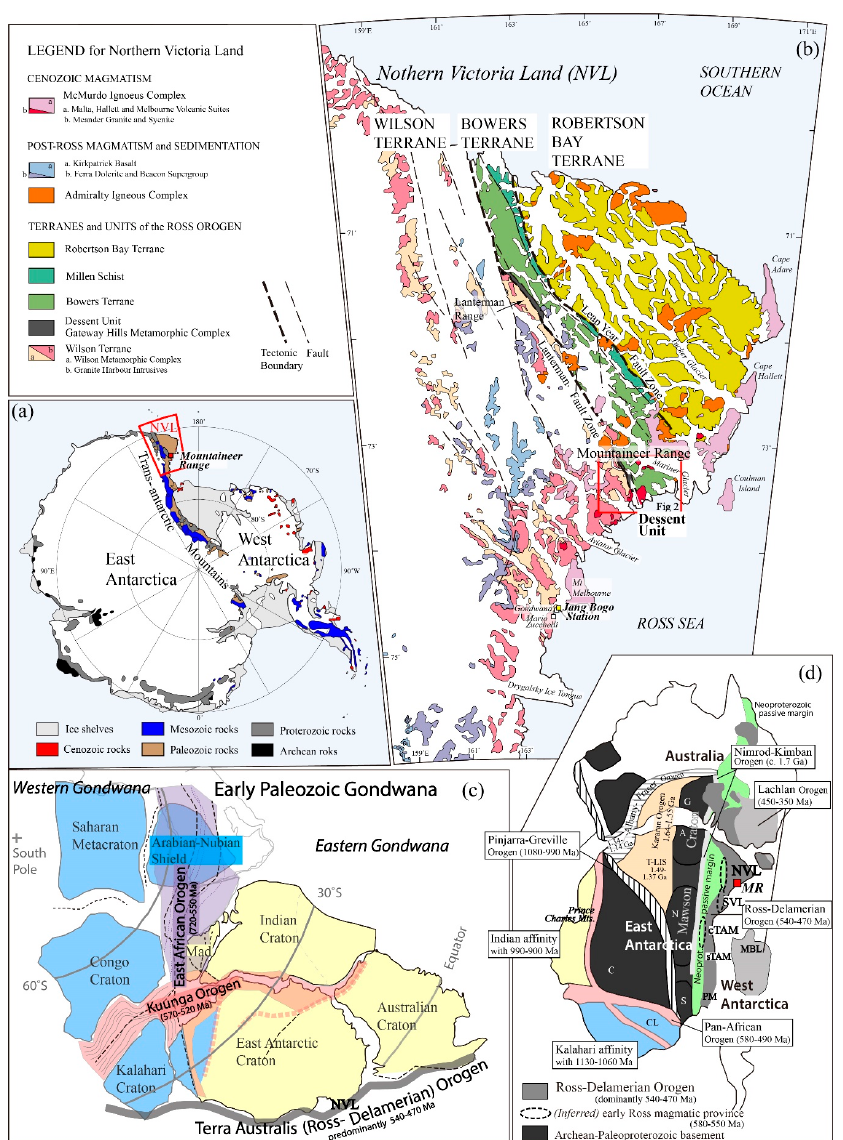
Figure 1. Geological map of Antarctica and Northern Victoria Land (NVL). ( a ) The simplified geological map of Antarctica with the NVL location (modified after Yi et al. [52]). ( b ) Geological map of NVL encompassing the Wilson (WT), Bowers (BT) and Robertson Bay terranes (RBT) and showing the study area (Mountaineer Range) (modified after Capponi et al. [43,44]). ( c ) East Antarctica and surrounding cratons in Gondwana during the early Paleozoic with the Pan-African (East African Orogen and Kuunga Orogen) and Terra Australis (Ross–Delamerian Orogen) belts (modified after Meert [2] and Tosvik and Cocks [6]). ( d ) Paleogeographic configuration of the Antarctic–Australia Craton during late Cretaceous to early Paleogene period and geological correlation of two cratons (modified after Boger [5], Goodge [26], Estrada et al. [39] and Foster and Goscombe [53]). Abbreviations: A, Terre Ad é lie Land; cTAM, central Transantarctic Mountains; C, Crohn Craton; CL, Coats Land Block; G, Gawler Craton; MR, Mountaineer Range; N, Nimrod Complex; PM, Pensacola Mountains; S, Shackelton Range; sTAM, southern Transantarctic Mountains; SVL, southern Victoria Land; T-LIS, Trans-Laurentian Igneous